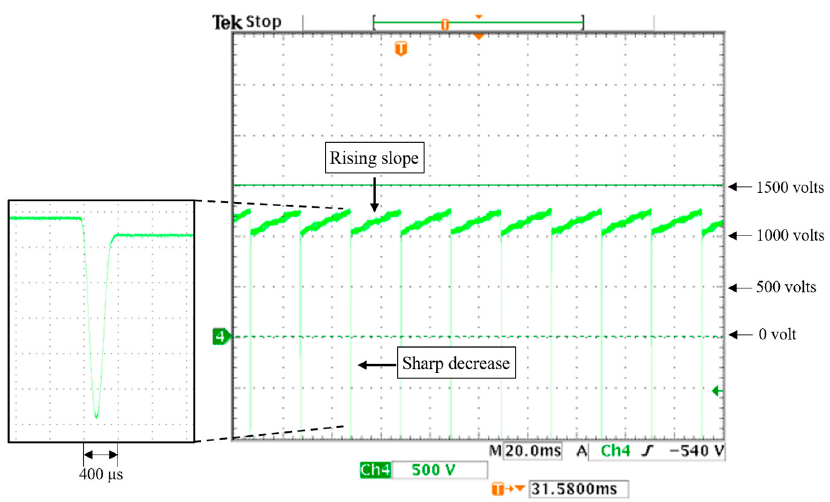
Figure 4. Changes in the capacitor voltage of the TSTM at 50 Hz stimulus frequency.